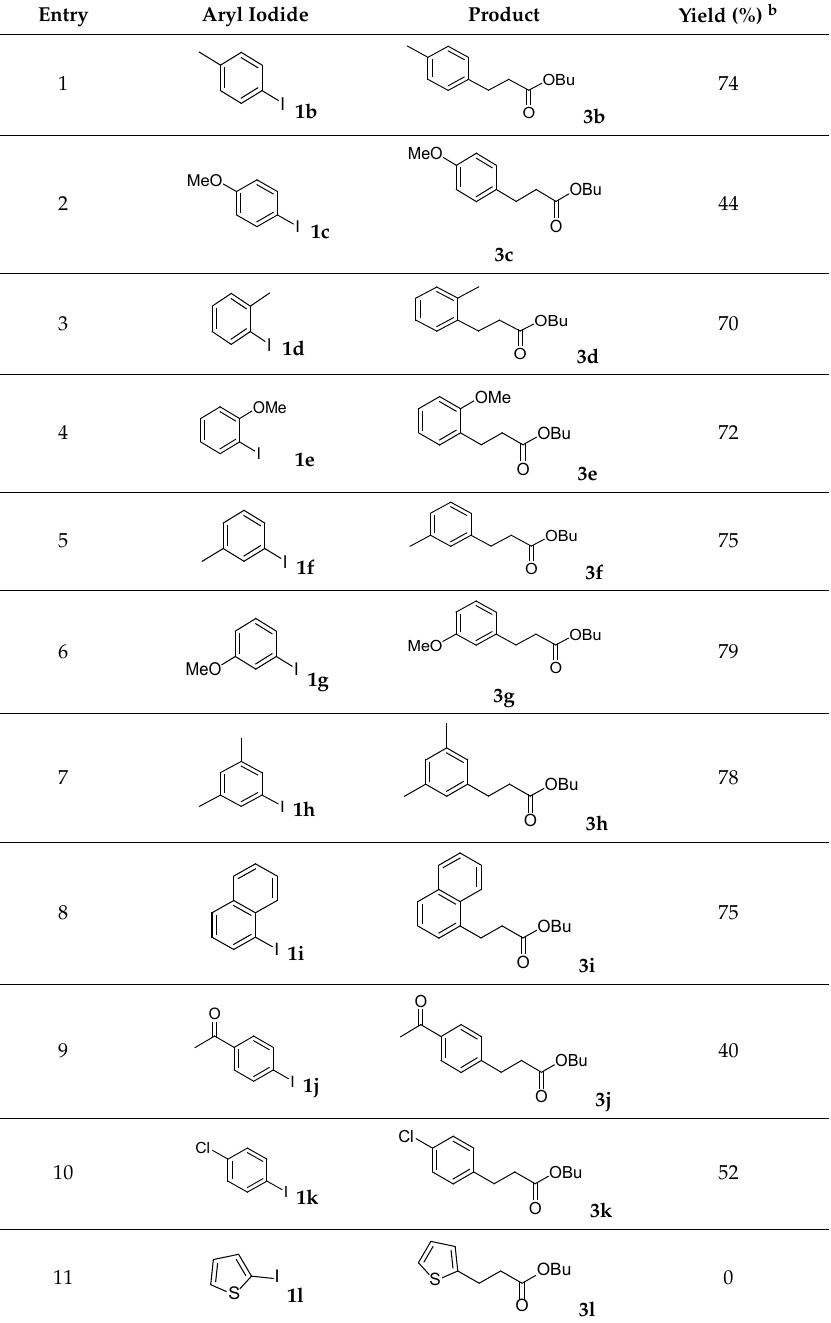
Table 2. Iron-catalyzed conjugate addition of aryl iodides ( 1 ) onto n -butyl acrylate ( 2a ) a .